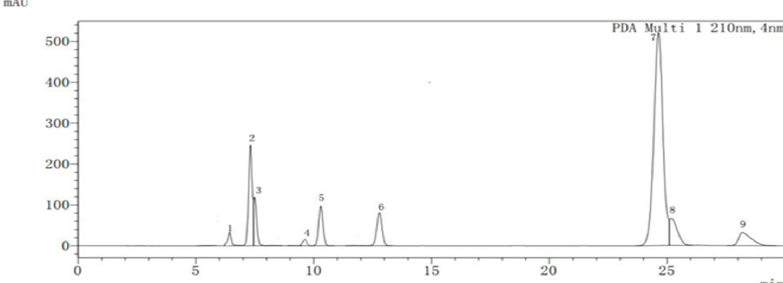
Figure 2. Chromatogram of organic acids in the fruit of Actinidia eriantha ‘Ganmi 6’ obtained at 210 nm.